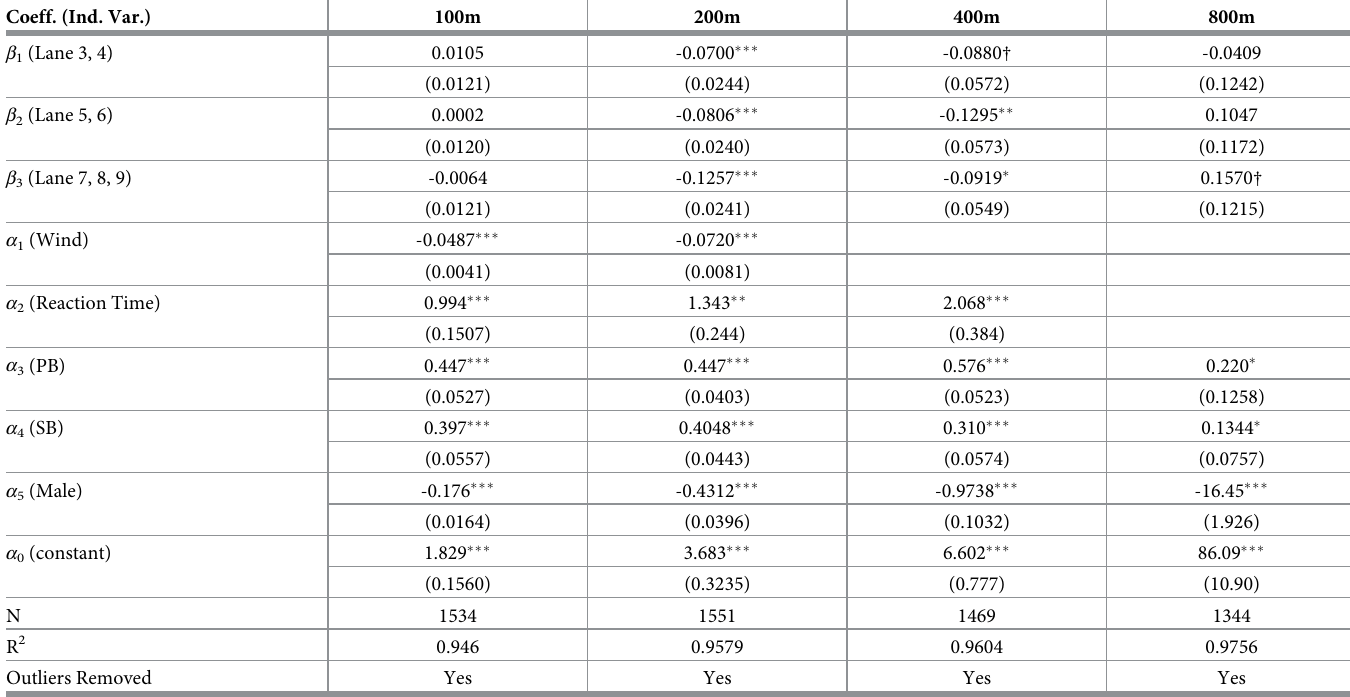
Table 7. Regression results for coarser lane groupings. Coeff. (Ind.